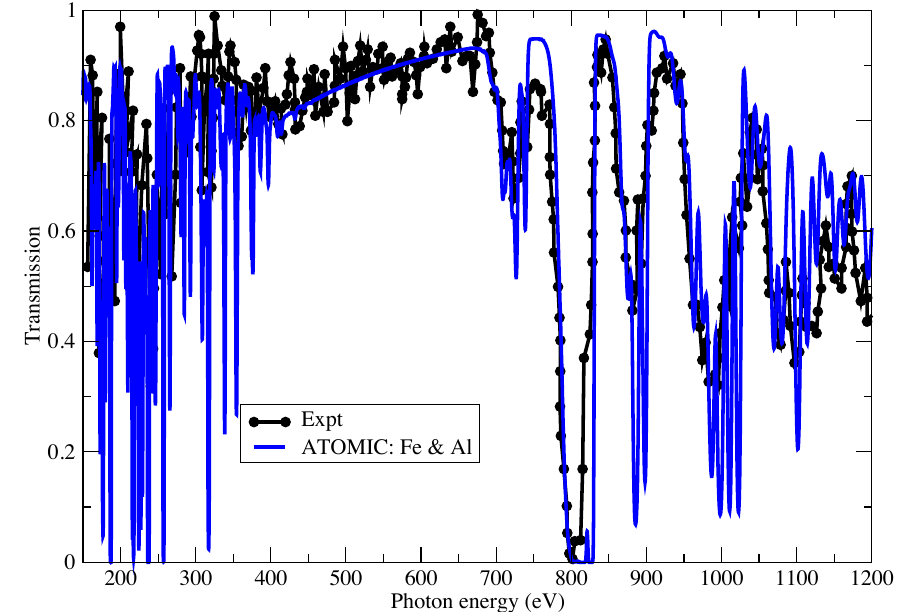
Figure 1. The transmission of Fe and Al as measured by Zhang et al. [29]. We compare the experimental data to ATOMIC calculations at a temperature of 72 eV and a mass density of 6 mg/cm 3